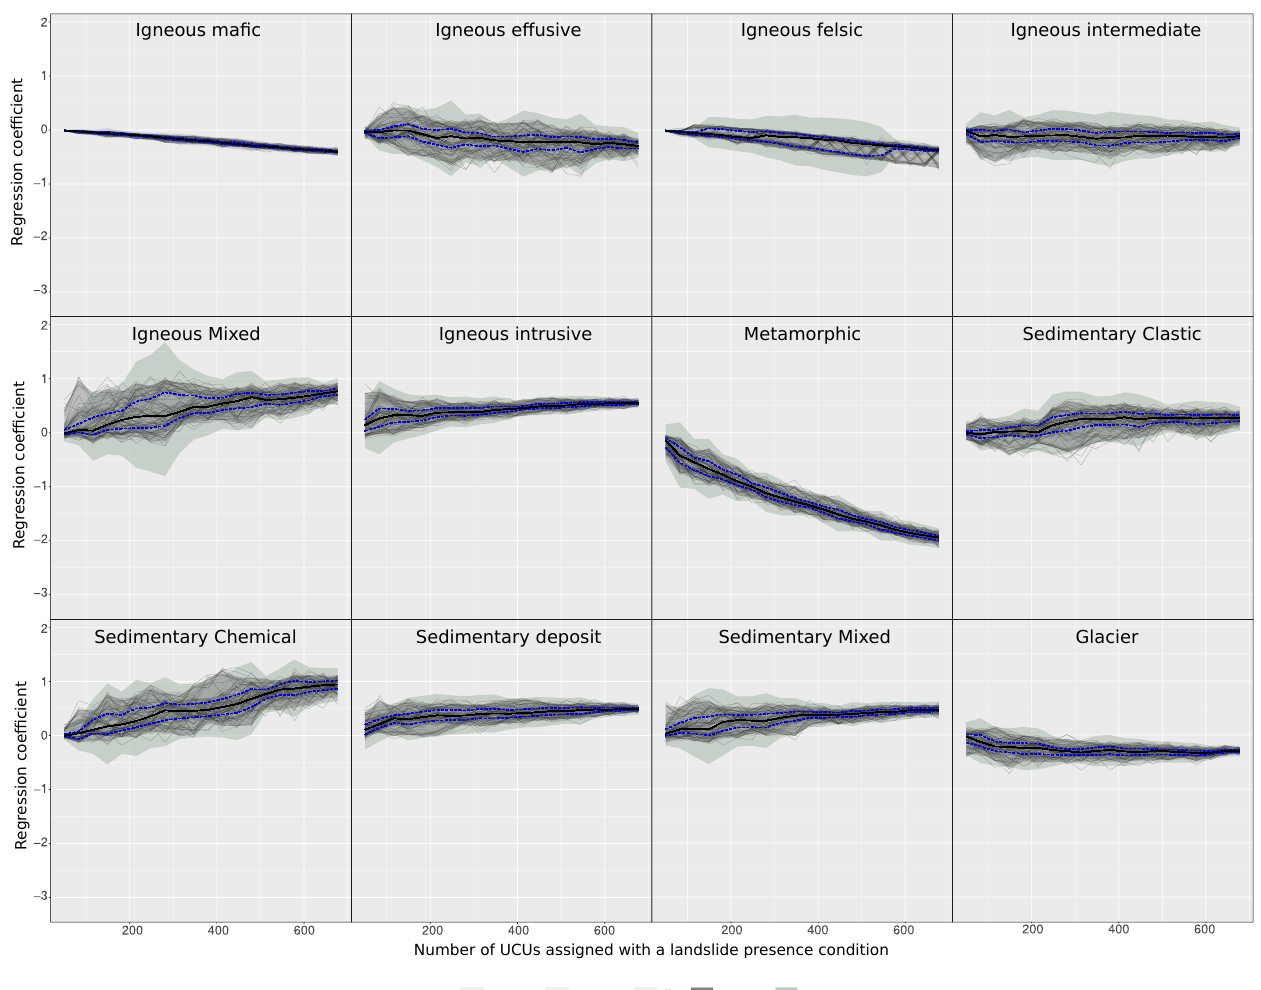
Figure A6. Lithology effect graphical summary at a varying proportion of landslide presence